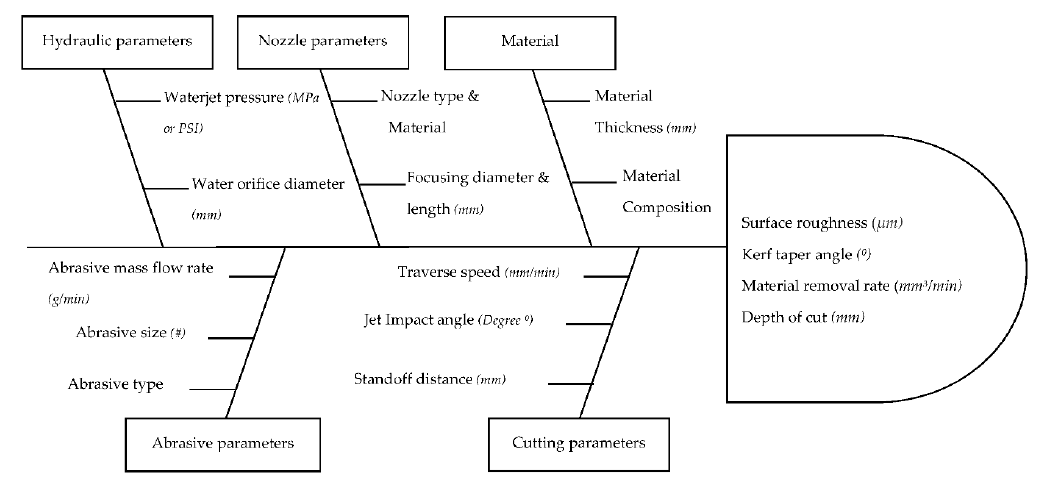
Figure 4. Cause-and-effect diagram of AWJM process parameters [9,81].